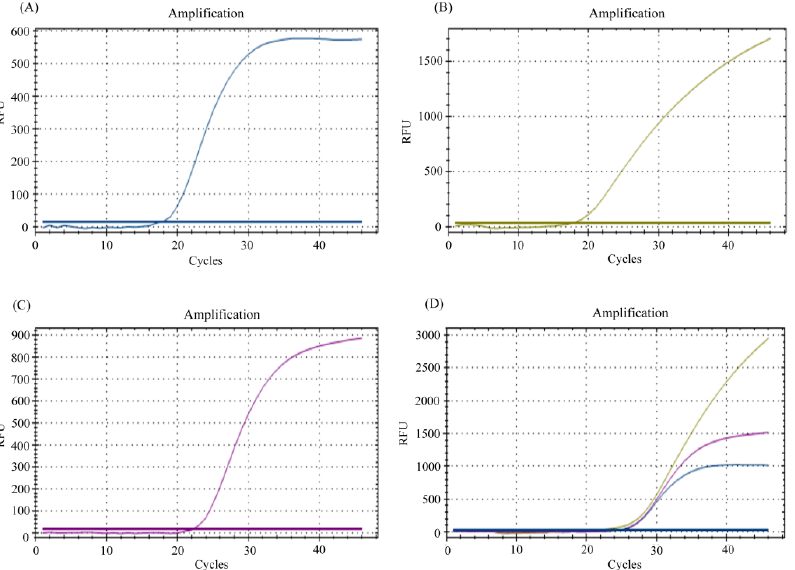
Figure 1. Amplification curves for each of the target genes in singleplex: ( A ) E gene, ( B ) N gene, ( C ) RNase P gene and ( D ) Multiplex assay with the optimized combination of primer-probes.